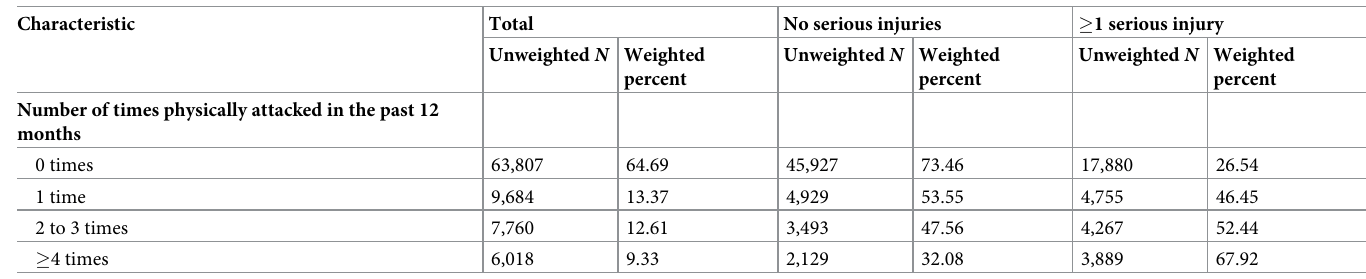
Results from the multivariable analysis of associations between indicators of psychosocial circumstances and type of injury, controlling for demographic and country-level factors but not adjusting for aggressive behaviour indicators, are shown in Table 5 and Figs 2 and 3. Con- sidering markers of risky behaviour, ever having used drugs was significantly associated with increased odds of broken bone/dislocated joint (OR 1.73, 95% CI 1.37 to 2.18, p < 0.001), cut or stab wound (OR 1.73, 95% CI 1.20 to 2.49, p = 0.004), and gunshot wound (OR 3.43, 95% CI 1.63 to 7.20, p < 0.001). Higher levels of physical activity were significantly associated with broken bone/dislocated joint (OR 1.33, 95% CI 1.11 to 1.60, p = 0.002), but there was no con- sistent relationship seen between other markers of risky behaviour and injury type. For contextual factors, being bullied was associated with increased odds of all types of injury, but there was not a consistent exposure response. Feeling lonely was associated with a greater odds of broken bone/dislocated joint (OR 1.29, 95% CI 1.02 to 1.65, p = 0.036), cut or stab wound (OR 1.44, 95% CI 1.00 to 2.07, p = 0.050), head injury (OR 2.33, 95% CI 1.13 to 4.82, p = 0.022), and burns (OR 1.75, 95% CI 1.08 to 2.84, p = 0.023), but only at higher levels of exposure. Going hungry was not strongly associated with any injury type. Protective factors were not associated with a lower odds of any type of injury apart from gunshot, where there was a lower odds in respondents with more understanding families or guardians (OR 0.56, 95% CI 0.34 to 0.93, p = 0.026). Considering indicators of poor mental health, attempting suicide was associated with a sig- nificantly increased odds of all injury types except burns (OR 1.34, 95% CI 0.84 to 2.15, p = 0.218). Being too worried to sleep was associated with an increased odds of a broken bone (OR at higher exposures, but relationships with other injury types were either non-significant at any exposure (cut or stab wound, gunshot wound, poisoned), or not consistent (bad burn). Associations between mechanism of injury and indicators of psychosocial circumstances, controlling for demographic and country-level factors but not adjusting for aggressive behav- iour indicators, are shown in Table 6. Considering markers of risky behaviour, smoking was associated with a greater odds of MVA at all exposures (OR 1.71, 95% CI 1.14 to 2.55, p < 0.001), and with a greater odds of falling and being attacked or abused or fighting but only at low exposure. Alcohol use was inconsistently associated with mechanisms across exposure lev- els. Ever having used drugs was associated with greater odds of MVA (OR 1.52, 95% CI 1.11 to 2.08, p = 0.001), being hit by a falling object (OR 1.88, 95% CI 1.18 to 3.00, p = 0.008), and being attacked or abused or fighting (OR 2.11, 95% CI 1.31 to 3.41, p = 0.002). Higher levels of physical activity were associated with falls (OR 1.47, 95% CI 1.18 to 1.83, p < 0.001, for � 3 days per week compared with none). Considering contextual factors, being hungry was associated with falls (OR 1.74, 95% CI 1.29 to 2.35, p < 0.001), being hit by a falling object (OR 2.08, 95% CI 1.29 to 3.35, p =